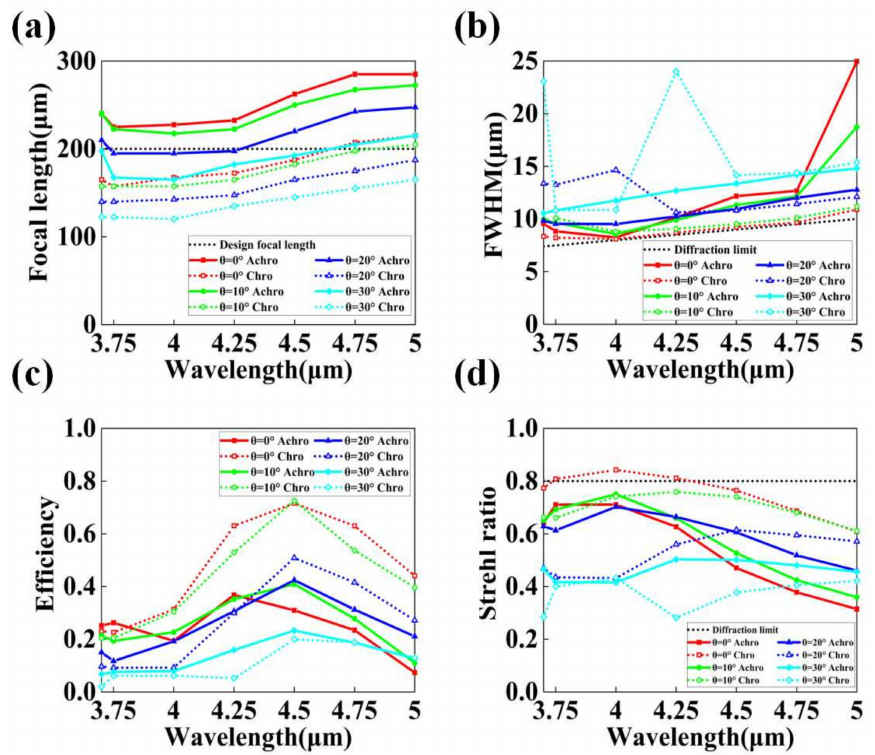
Figure 7. ( a ) Actual focal lengths of the achromatic and the chromatic lenses at different incident angles θ and different wavelengths. The black line represents the designed focal length (200 µ m) of the metalens. ( b ) The FWHM of the focal spots for the achromatic and the chromatic lenses at different incident angles θ and wavelengths. The black line represents the ideal diffraction limit of the metalens. ( c ) Focusing efficiencies of the achromatic and the chromatic lenses at different incident angles θ and different wavelengths. ( d ) Strehl ratios of the focal spots for the achromatic and the chromatic lenses at different incident angles θ and different wavelengths. The black line represents the minimum value of the Strehl ratio (0.8) that can be considered a diffraction limited lens. In all figures, solid lines represent simulation results for the achromatic lens, and dashed lines represent simulation results for the chromatic lens. The red, green, blue, and cyan lines represent the inclination angle θ = 0 ◦ , 10 ◦ , 20 ◦ , and 30 ◦ of the incident light,